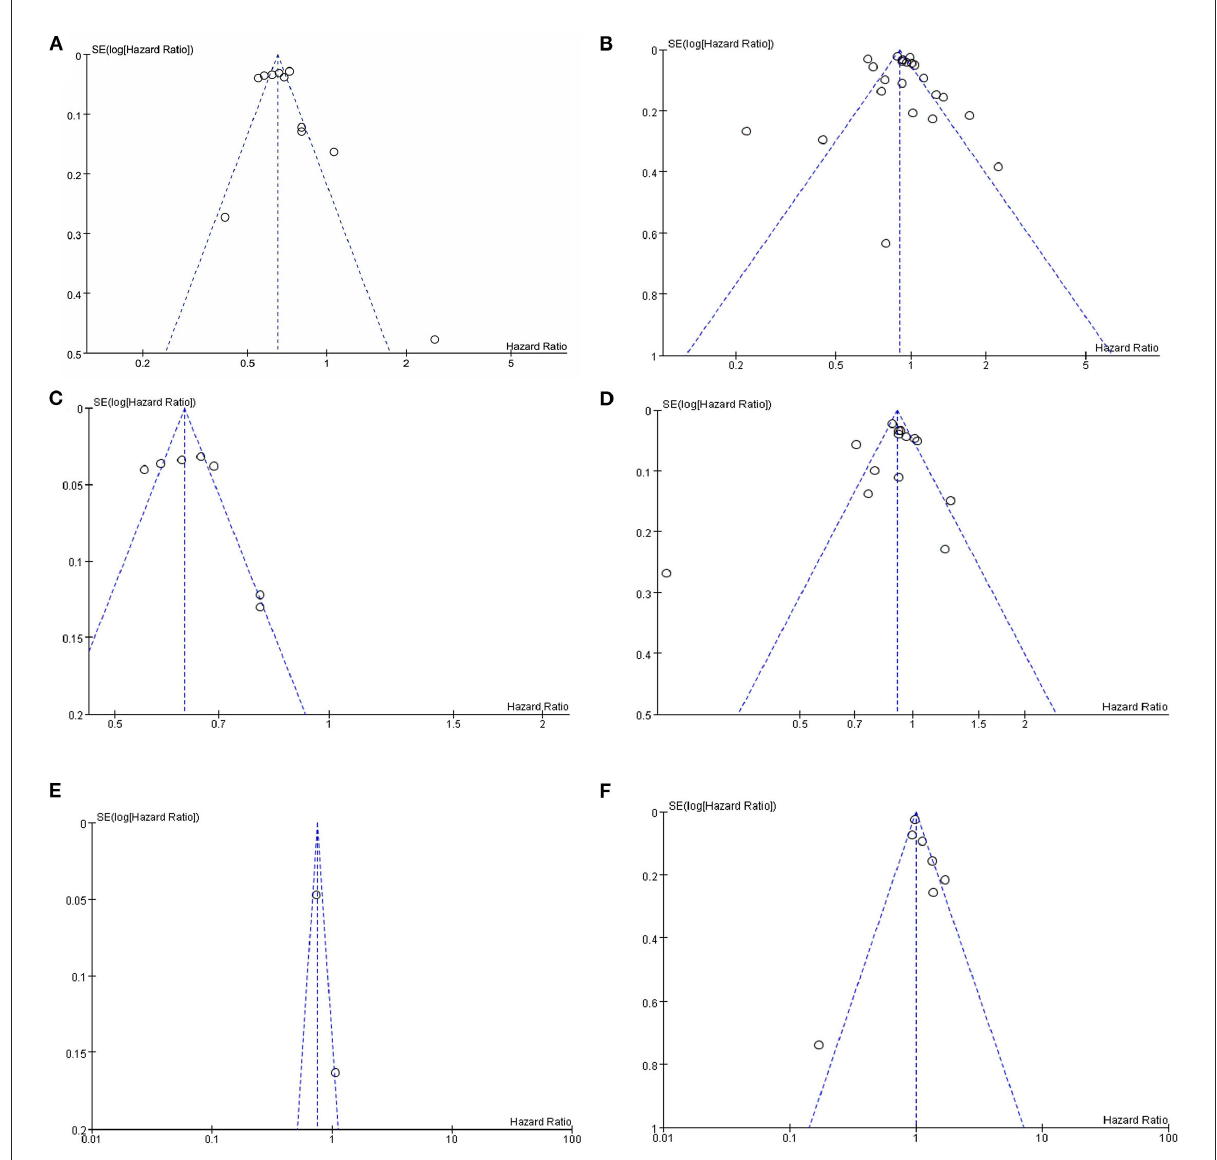
FIGURE6 Assessment of publication bias by funnel plots of metformin on cognitive dysfunction in patients with diabetes included observational studies. (A) All studies (unadjusted covariates); (B) All studies (adjusted covariates); (C) Subgroup meta-analysis on dementia (unadjusted covariates); (D) Subgroup meta-analysis on dementia (adjusted covariates); (E) Subgroup meta-analysis on AD (unadjusted covariates); (F) Subgroup meta-analysis on AD (adjusted